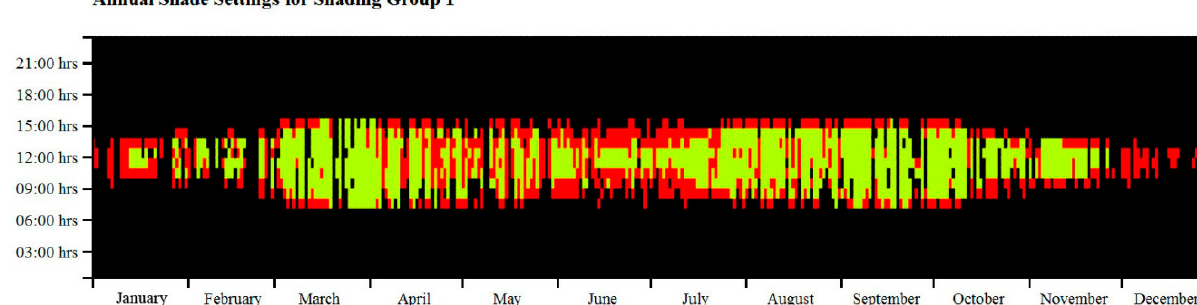
Figure 10. An annual plot (365 days × 24 h) of the shade conditions created on a particular window group based on a selected shade control algorithm. The shades are controlled to two different settings (indicated by the colors) in addition to open (the black area on this